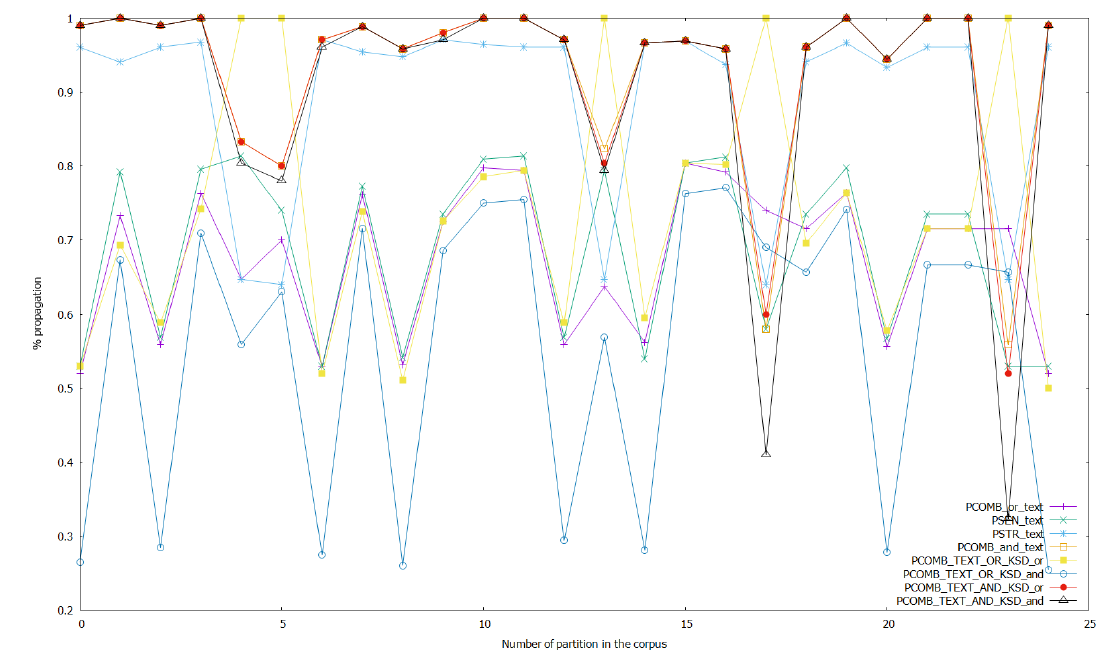
Figure 12. Results of the experiments with the sentiment, stress, and combined analyses on text, and with the combined analyses on text and keystroke data with threshold set to 0.7 in the ANNs that perform stress analysis.